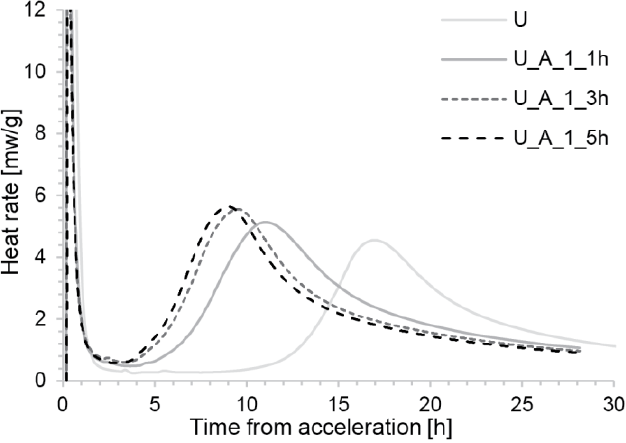
Figure A1. Heat flow over time from time of acceleration for the U mix accelerated with uniform dosage of aluminium sulfate.